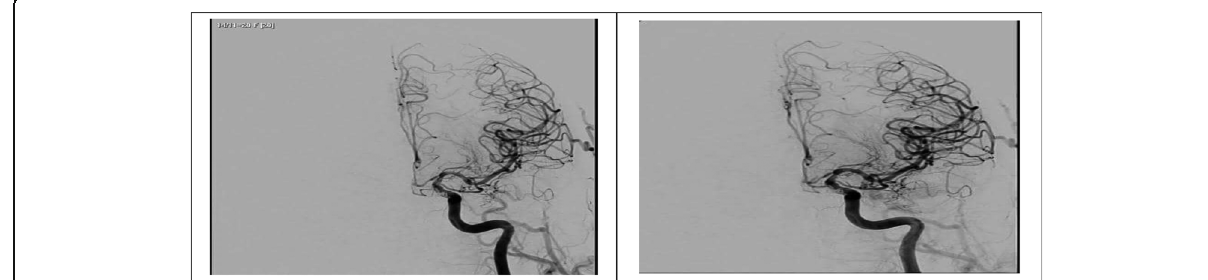
Fig. 2 Patient with basilar artery vasospasm (left) undergo interventional intra-arterial nimodipine injection with good improvement of the vasospasm